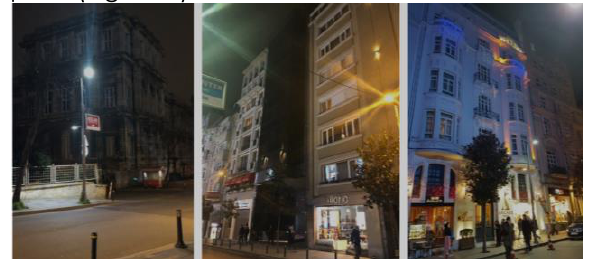
Figure 8. Façade Lighting (photo by authors)